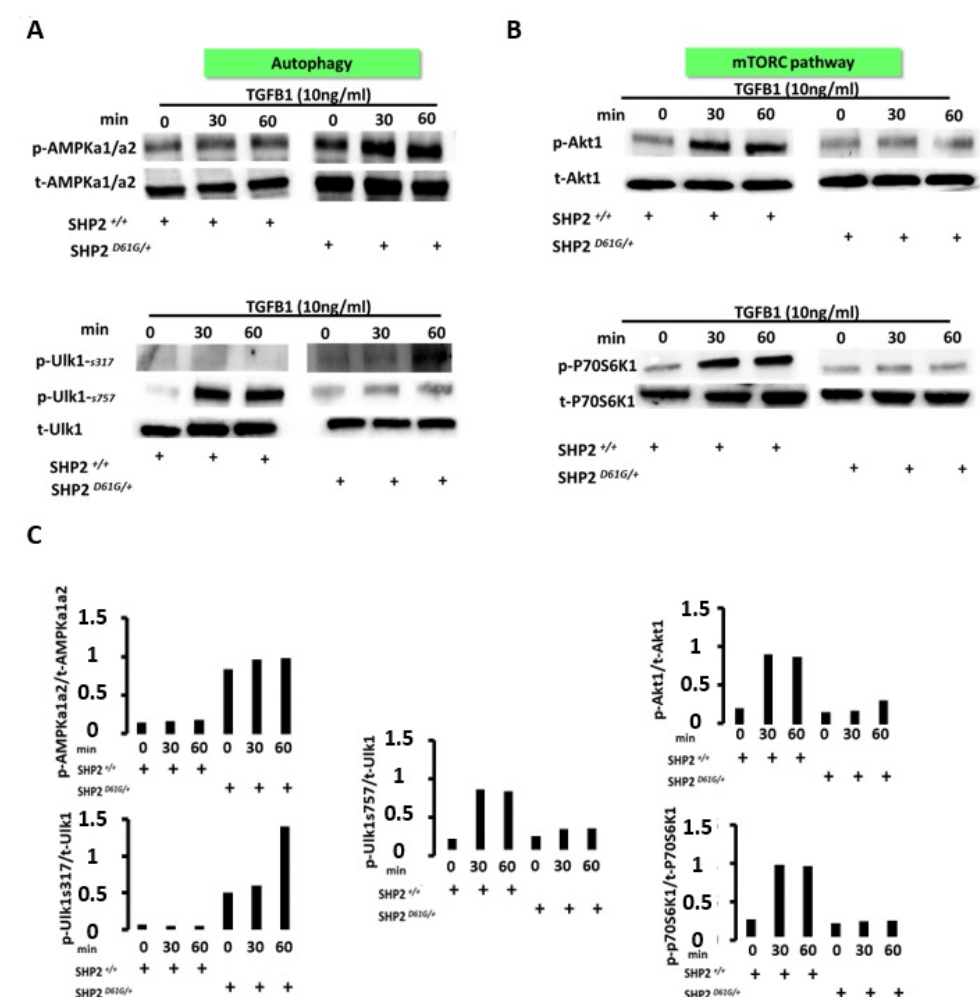
Figure 4. Immunoblot analysis showing that SHP2 positively regulates phosphorylation states of autophagy-related kinases and negatively regulates mTORC1 signaling pathways. ( A ) Autophagy signaling pathway: SHP2 constitutive activation augments TGFB1-induced phosphorylation of AMPKa1/a2 while baseline SHP2 expression leads to dephosphorylation of AMPK serine/threonine kinase complex. SHP2-induced AMPK activation led to enhanced phosphorylation of Ulk-1 at serine 317 while it dephosphorylated Ulk-1 at serine 757. ( B ) mTORC1 signaling pathway: SHP2 constitutive activation in DG1G+ mutants was associated with reduced TGFB1-induced phosphorylation of Akt-1 and p-P70S6K1, indicating inhibition of mTORC1 signal transduction pathway. Each lane represents an individual cell preparation. ( C ) Immunoblot densitometry analysis of p-AMPK-a1/a2 normalized to total AMPK-a1/a2, p-Ulk-1-ser317, p-Ulk1-ser757 normalized to total Ulk-1, p-Akt-1 normalized to total Akt-1 and p-P70S6K1 normalized to total P70S6K1. Data are presented as bar graphs. Each bar represents an individual lane. Details for this fi gure are presented in Supplemental Data S4.